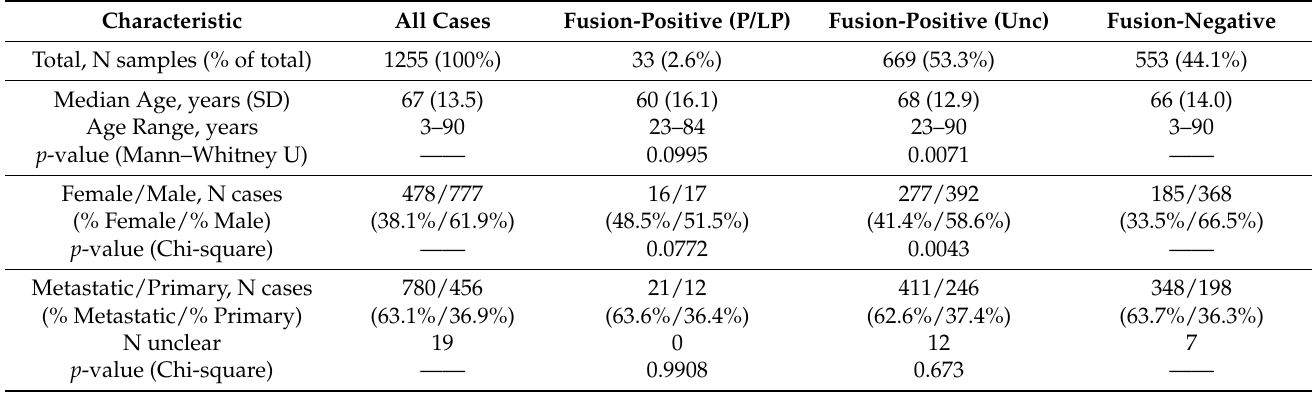
Table 1. Patient cohort characteristics. Fusion-positive samples include those with one or more unique fusion transcripts detected, which were further stratified based classification of fusion transcripts as pathogenic/likely pathogenic (P/LP) or unclassified (Unc). p -values reflect the comparison with the fusion-negative cohort.